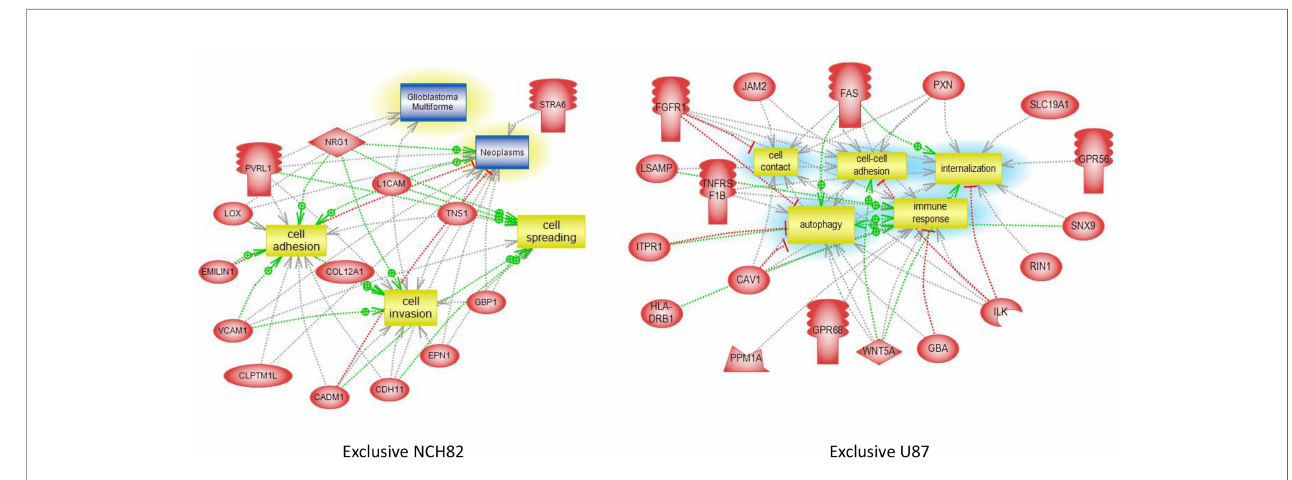
FIGURE 3 | Global pathway analyses of proteins only expressed by NCH82 and U87 GBM cell